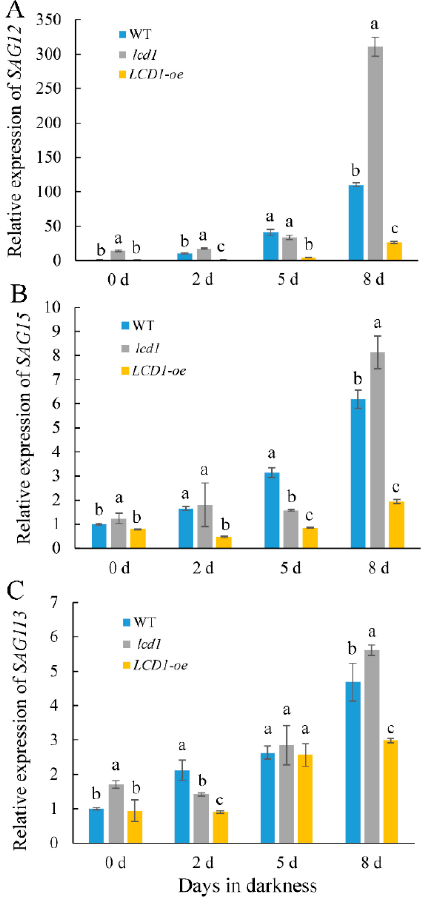
Figure 6. Changes in the gene expressions of senescence-related genes: ( A ) SAG12 , ( B ) SAG15 , and ( C ) SAG113 in detached leaves of 6-week-old wild-type (WT), lcd1 , and LCD1-oe tomatoes stored in darkness for 0, 2, 5, and 8 days. Data are means of three biological replicates ± standard deviation (SD). Different letters above the columns stand for significant difference between two values ( p < 0.05) at the same time point.